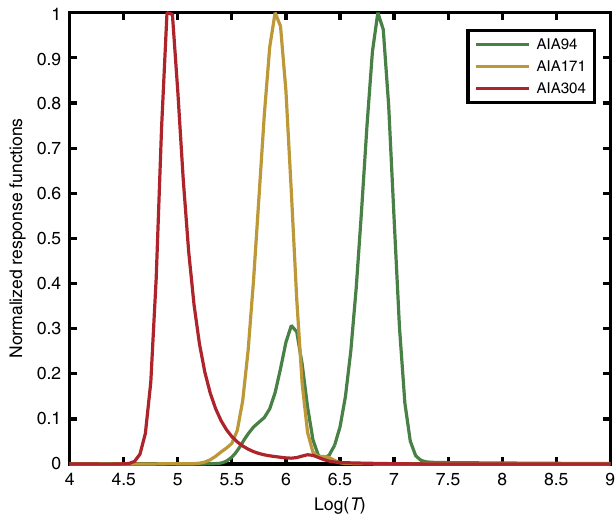
Figure 6 | The normalized response functions of the AIA channels. The normalized response functions of the AIA 94Å (green line), 171Å (yellow line) and 304Å (red line) channels plotted against log 10 of T (temperature). The AIA 94Å channel has its largest sensitivity peak close to 10MK but it is not limited in sensitivity to that specific temperature. It is shown in the green line that the AIA 94Å channel has a secondary peak with maximum at the temperature of